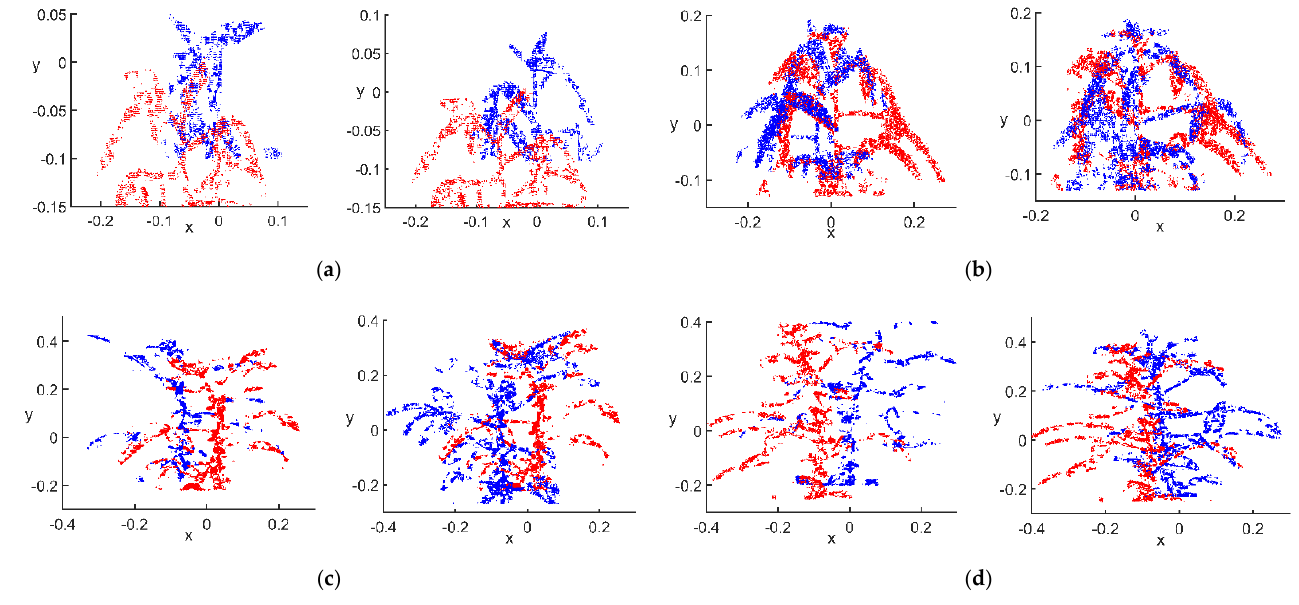
Figure 7. Points with above-average eigenvalues: ( a ) flowering stage; ( b ) podding stage; ( c ) filling stage; ( d ) mature stage. stage; ( d ) mature stage.